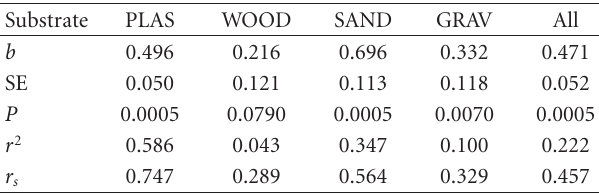
Table 4: Results of linear regressions through the origin (zero intercept) of both Z -transformed values of stride frequency (SFR) and relative stride length (RSL). The angular coe ffi cients ( b ), their respective standard errors (SE), and P values are shown with the coe ffi cients of determination ( r 2 ) and the Spearman correlation coe ffi cients ( r s ). Sample size is n = 72 for each substrate and n = 288 for all substrates pooled. Only WOOD × SAND ( t = 2 . 1, P < 0 . 05) resulted in a significant pairwise contrast among slopes for di ff erent